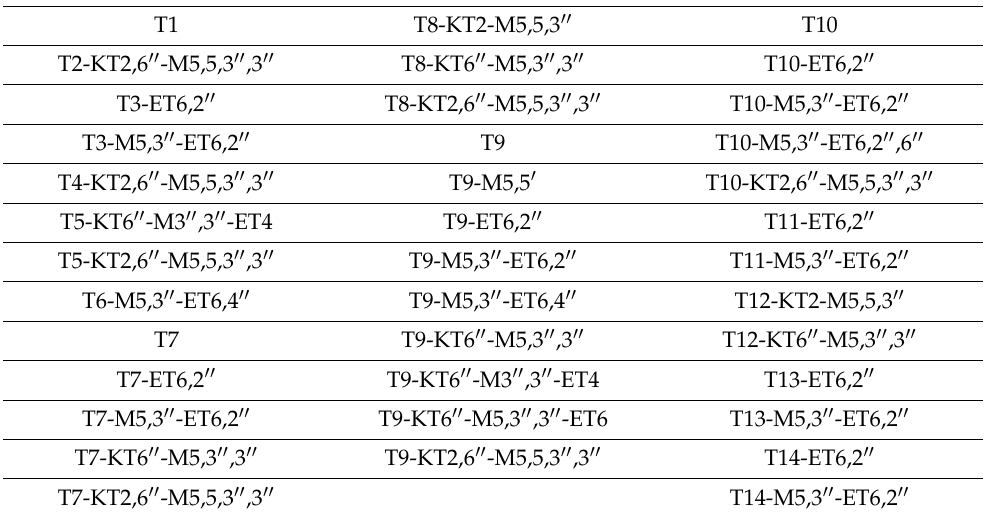
Table 2. List of the calculated trimeric acylphloroglucinols. The molecules are denoted using acronyms. The meaning of the initial components of the acronyms (indicating the nature of the R chains of the three monomeric units) is explained in Table 1. Substituents on the outer rings are denoted by uppercase letters followed by the number of the C atoms to which a given substituent is attached; M denotes a methyl group, ET an OCH 3 group, and KT a keto O. The atom numbering is shown in Figure